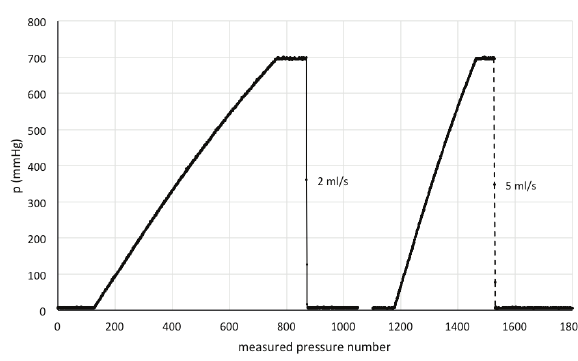
Figure 1: Slew rate dp/dt depended on gas-flow rate of a pressure transducer with about 0.1 mm 3 dead space, Flow rate: 2 ml/min (left), 5 ml/min (right), Sampling rate: 50 per second